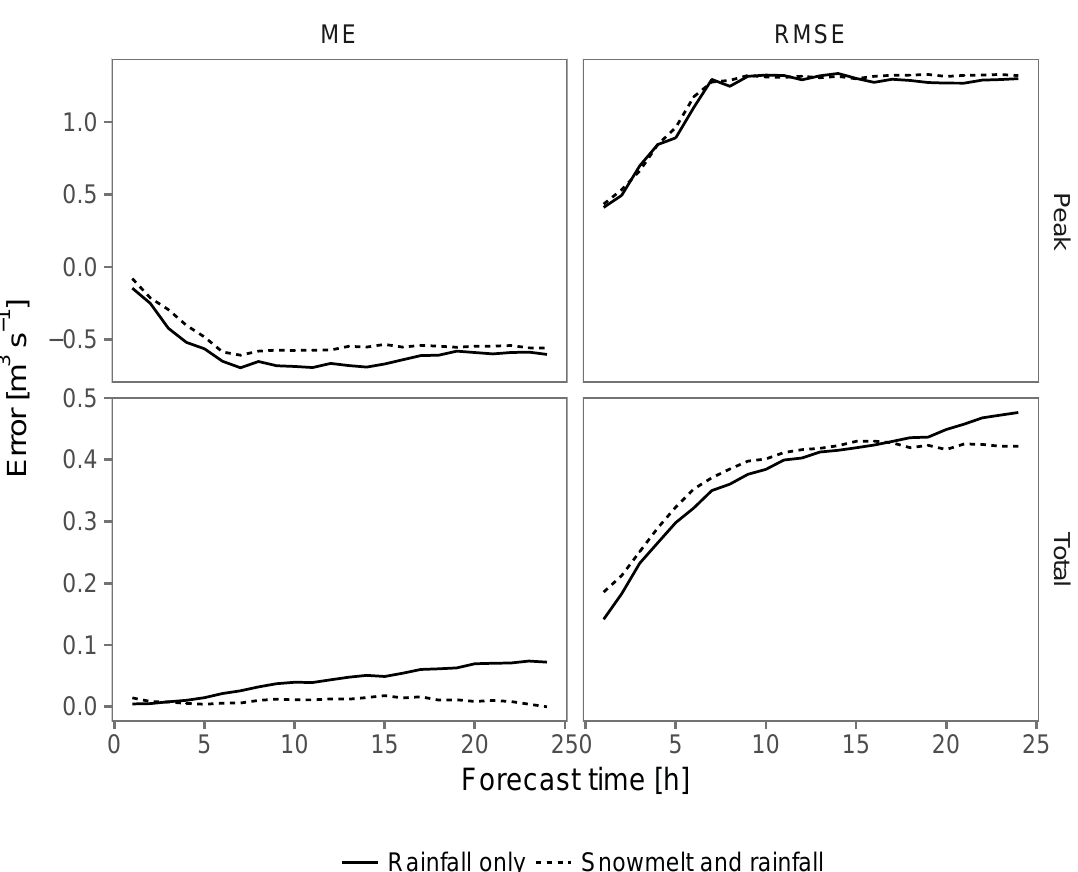
Figure 6. The mean error (ME, left panels) and root mean square error (RMSE, right panels) of the discharge forecasted with the Random Forests models for the validation period for the forecast time t from 1 to 24 h. Top panels present errors for the peak discharge events as indicated in Figure 1; the bottom panels present the total validation time series